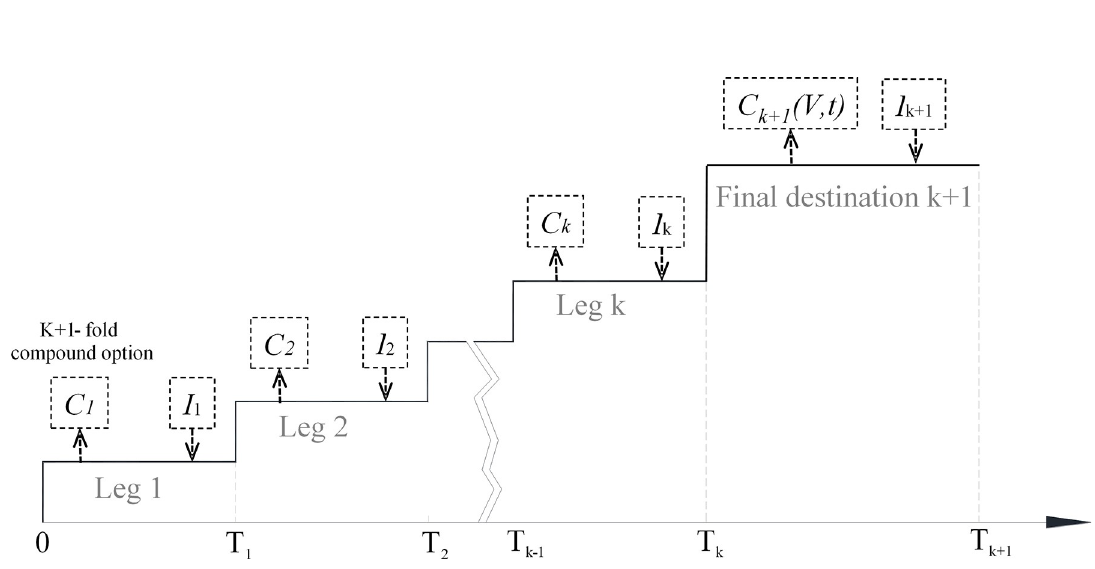
Fig 4. A refugee route as a k+1-stage compound option. Source: Author’s own elaboration.